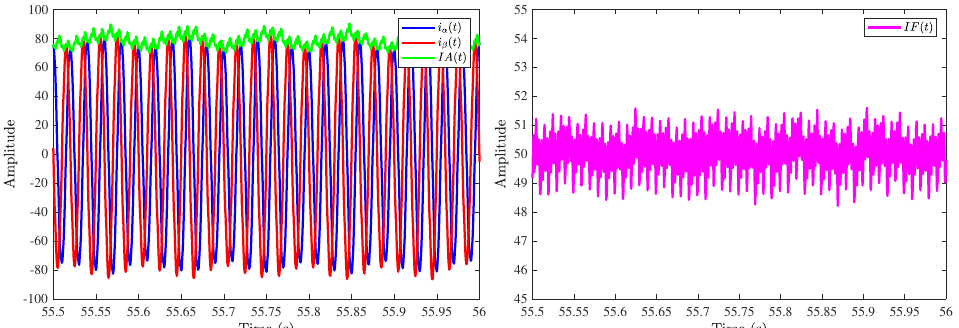
Figure 11. Measured currents in the Concordia reference frame, from 55.5 to 56 s.